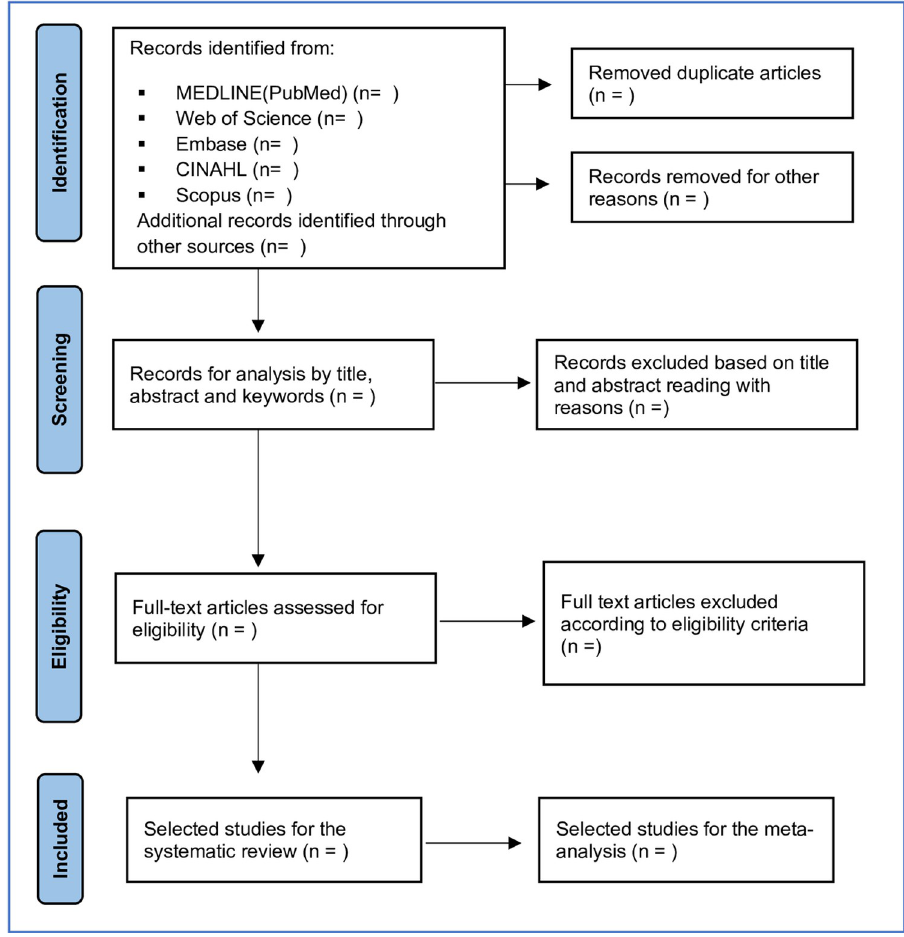
Fig 1. Flowchart for the selection of articles based on